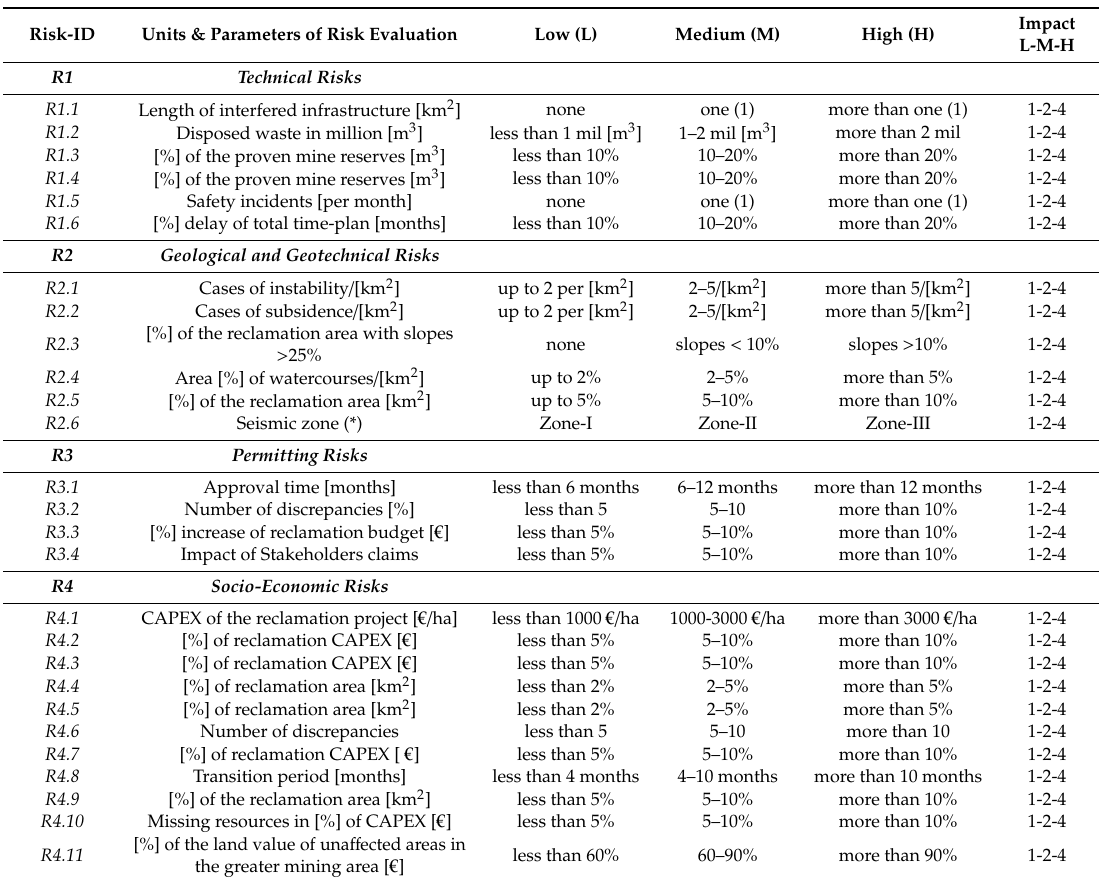
Table 6. Classification of Risk Severity